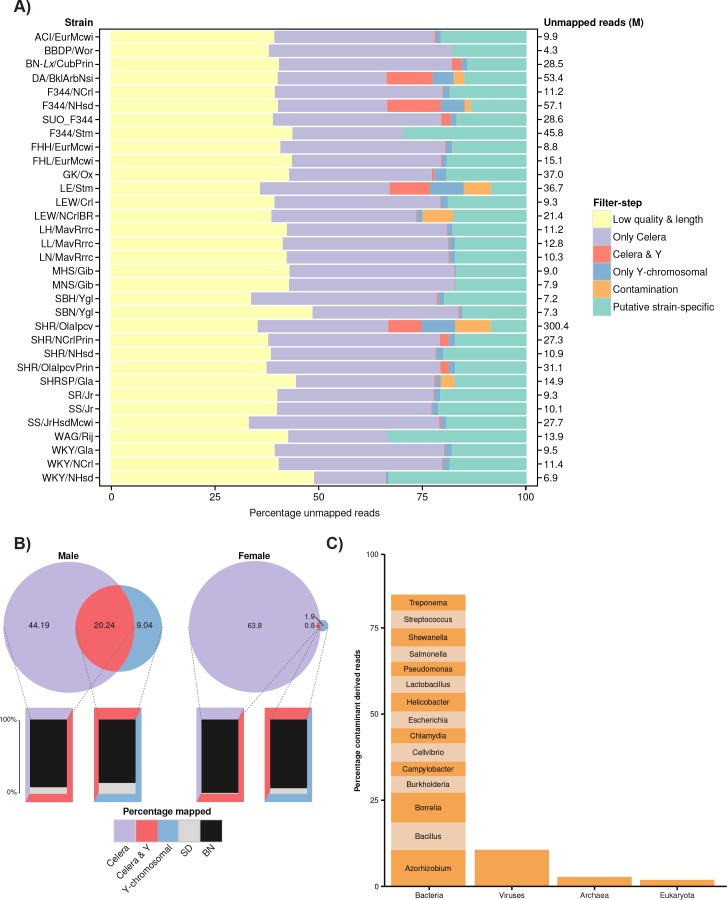
Origins of Unmapped reads.A) Stacked bar-graph of the origins of unmapped reads per strain. Total number of unmapped reads (millions) per strain is displayed on the right vertical axis. B) Distribution of reads, mapping to the alternative reference genome (Celera) and/or to the Y-chromosomal BAC-contigs of SHR/Akr, for male and female samples. C) Contaminant contribution in the twelve samples with contaminant-derived reads. The used contaminant-database consists of RefSeq-genomes of bacteria, viruses and fungi.